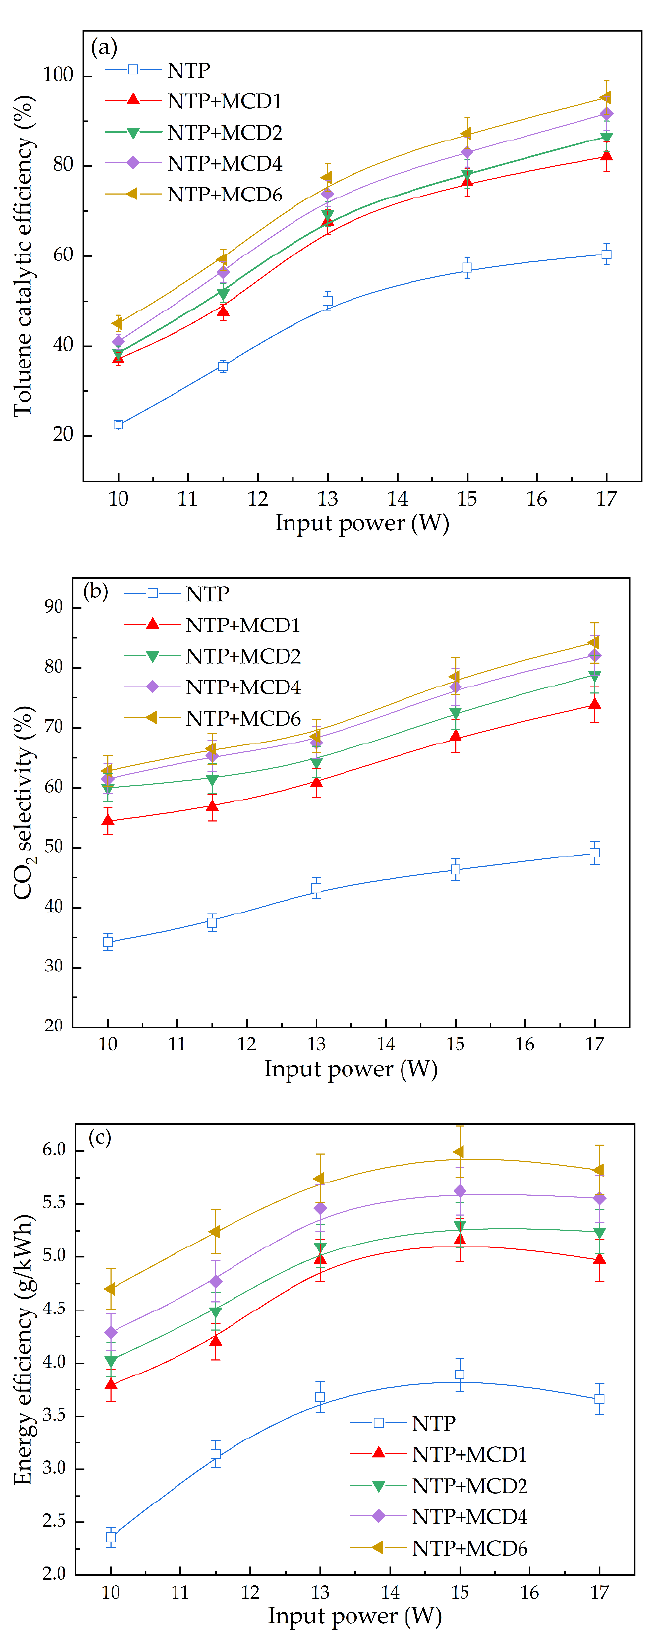
Figure 7. Effect of input power on synergetic catalytic performance of toluene: ( a ) catalytic reactiv- ity; ( b ) CO 2 selectivity; ( c ) energy efficiency.